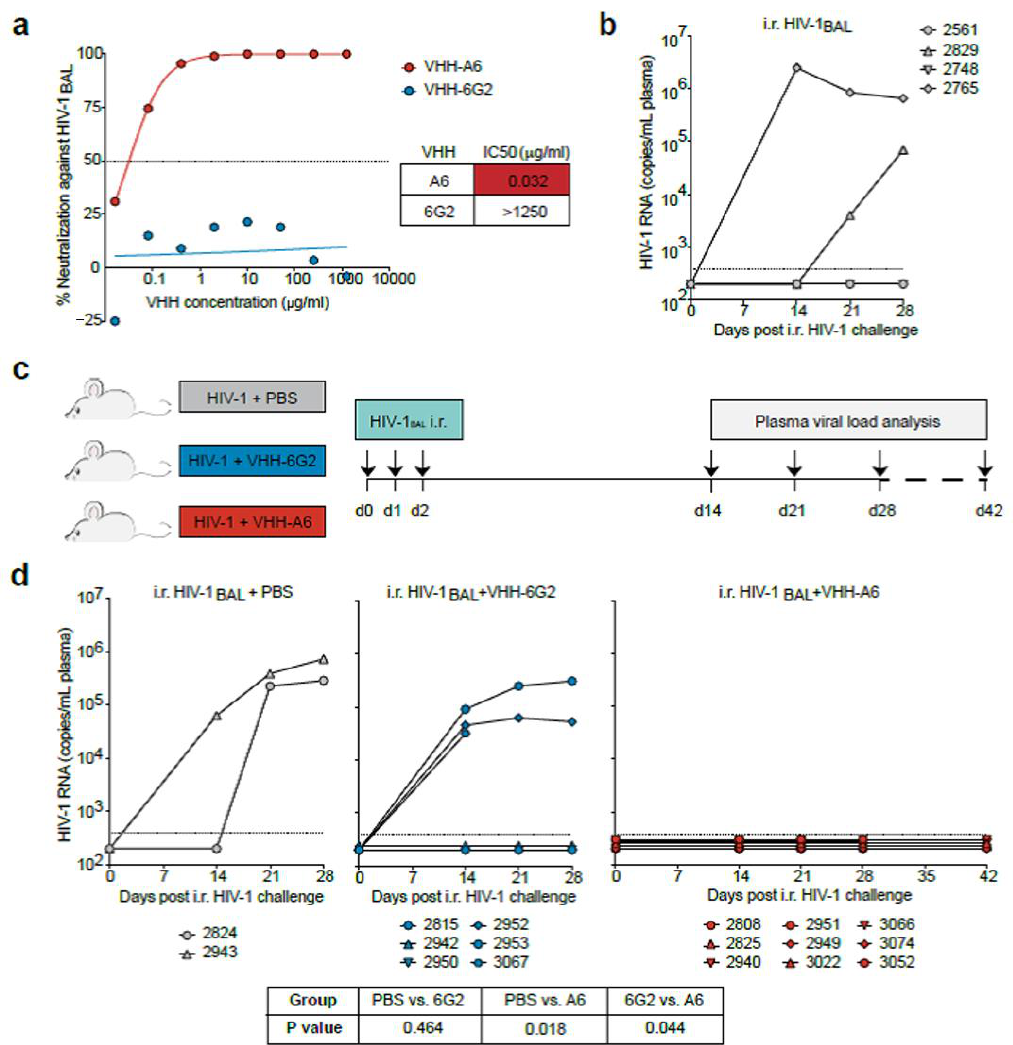
Figure 1. VHHA6-mediated prevention of mucosal HIV-1 infection in humanized mice. ( a ) Neutralizing activity of anti-HIV-1 VHHA6 and control VHH6G2 against the HIV-1 BAL infectious molecular clone (IMC) using TZM-bl cells. Dotted line represents the IC 50 . ( b ) Analysis of HIV-1 RNA levels in CD34T + mice (N = 4) following high-dose intra-rectal (i.r.) HIV-1 BAL challenges on two consecutive days. Dotted line represents the quantification limit of 384 HIV-1 RNA copies / mL of the qPCR assay. ( c ) Schematic representation of the experimental design used to test VHHA6–mediated HIV-1 prevention. CD34T + humanized mice were given high-dose i.r. challenges with HIV-1 BAL mixed with either PBS (N = 2), 50 µ g control VHH6G2 (N = 6) or 50 µ g anti-HIV-1 VHHA6 (N = 9) on three consecutive days and plasma viremia was tracked over time. ( d ) Analysis of HIV-1 RNA levels in the di ff erent CD34T + mouse groups as described in ( c ). Dotted line represents the quantification limit of 384 HIV-1 RNA copies / mL of the qPCR assay. Statistical analysis in ( d ) was done using Fisher’s exact